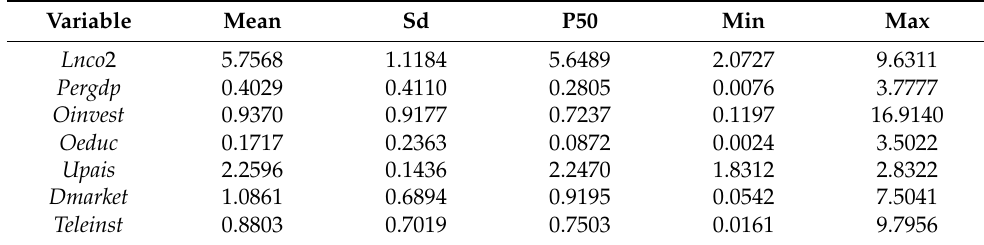
Table 1. Descriptive statistics of the